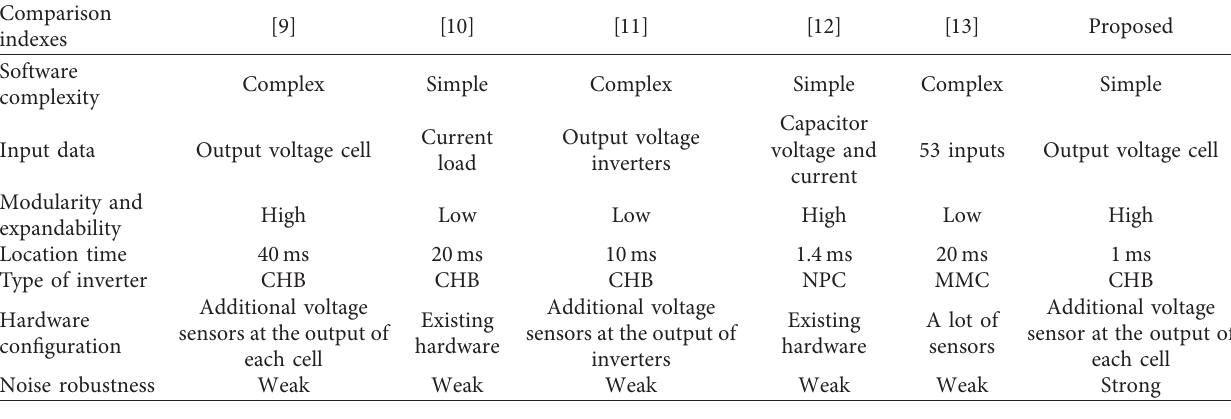
Table 3: Comparison of detected fault method for multilevel inverters.